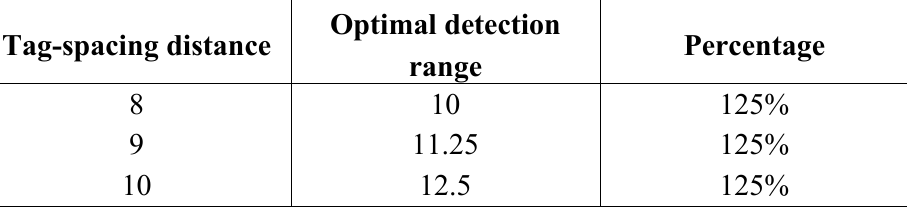
Table 2. Optimal detection range in 1-dimensional space.